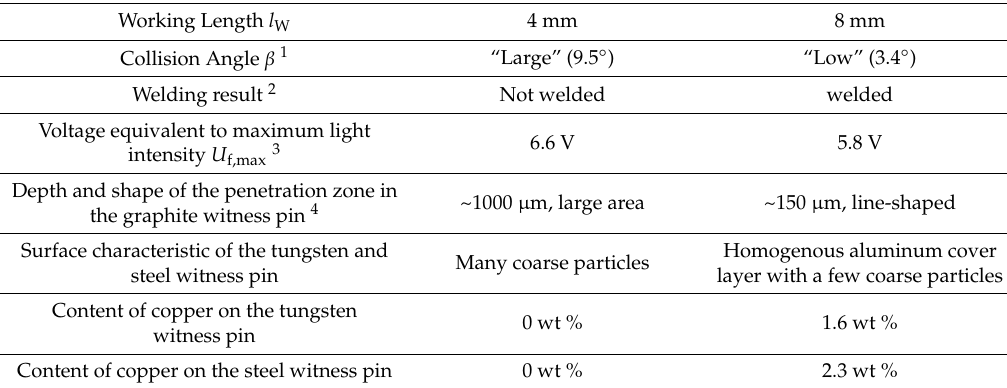
Figure 12. ( a ) Detailed sketch of the joining setup and witness pins to study ( b ) the influence of the collision angle on the indentation depth of the CoP into the graphite witness pin (0 μ m ‐ position of the pin is in contact with the inside of the flyer tube during MPW). Table 6. Influence of the collision angle on the process glare and interaction between the CoP and the witness pins.